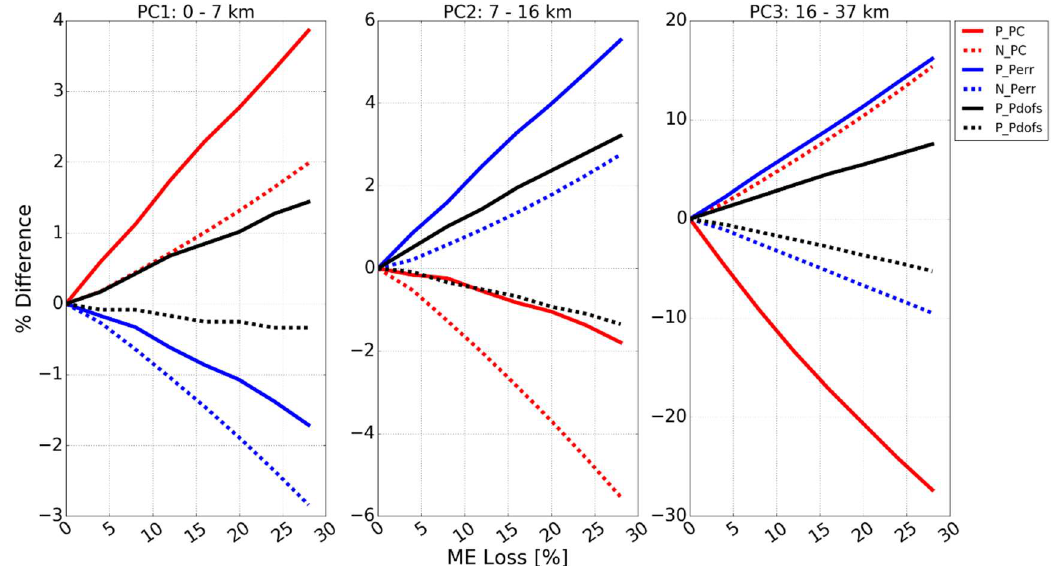
Figure 4. The same as Figure 2 but for CH 4 .